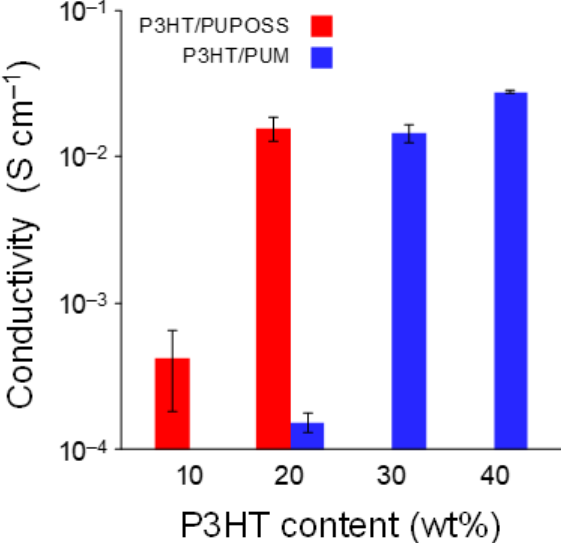
Figure 3. In-plane conductivities of P3HT/PUPOSS and P3HT/PUM.